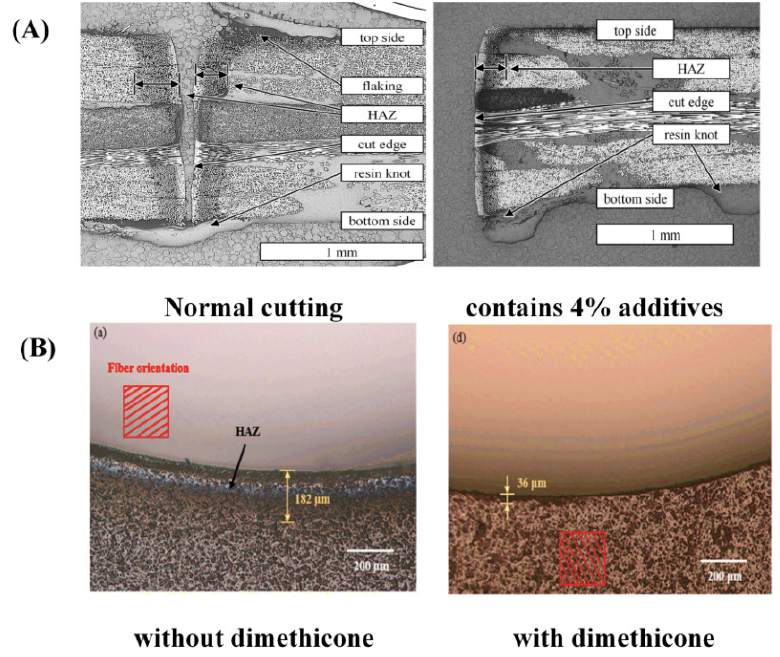
Figure 13. The effect of auxiliary agents on laser processing: ( A ) CFRP morphology after carbon- black-assisted laser processing and conventional laser processing [94]; ( B ) CFRP morphology after dimethylidene-ketone-assisted laser processing and conventional laser processing [95].